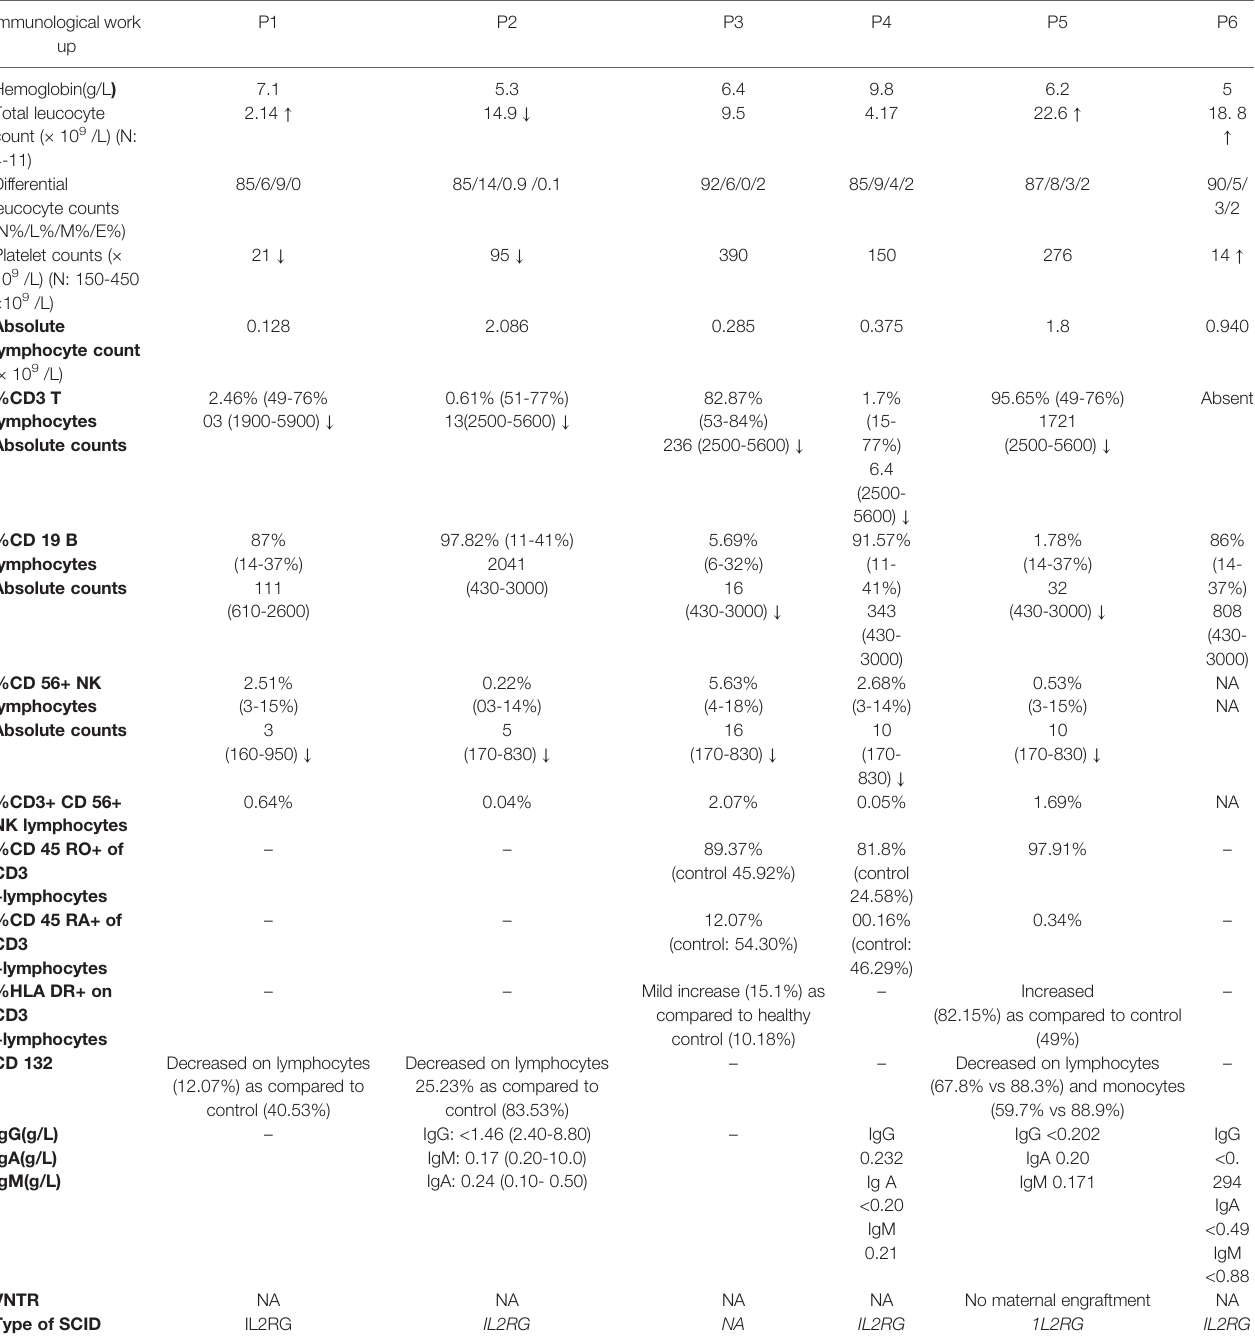
TABLE 2 | Immunological work-up of patients with SCID and HLH-like manifestations at the time of SCID diagnosis. Immunological work